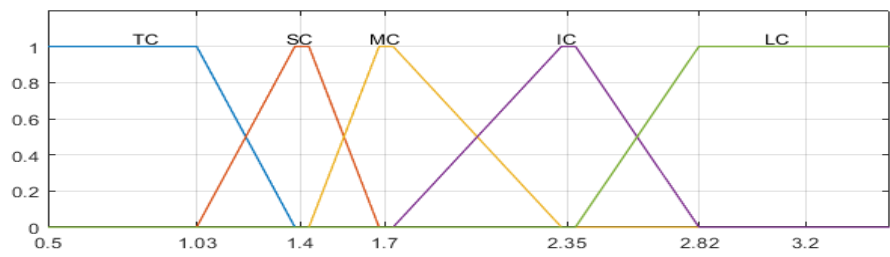
Figure 6. Input current membership functions.